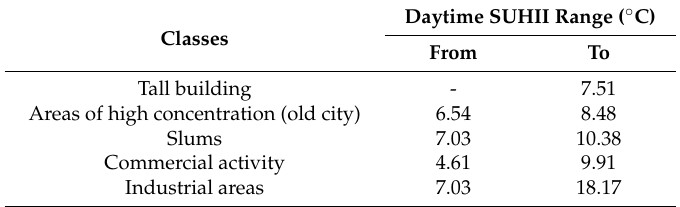
Table 3. Variation of daytime SUHII within areas exposed to intense anthropogenic heat.